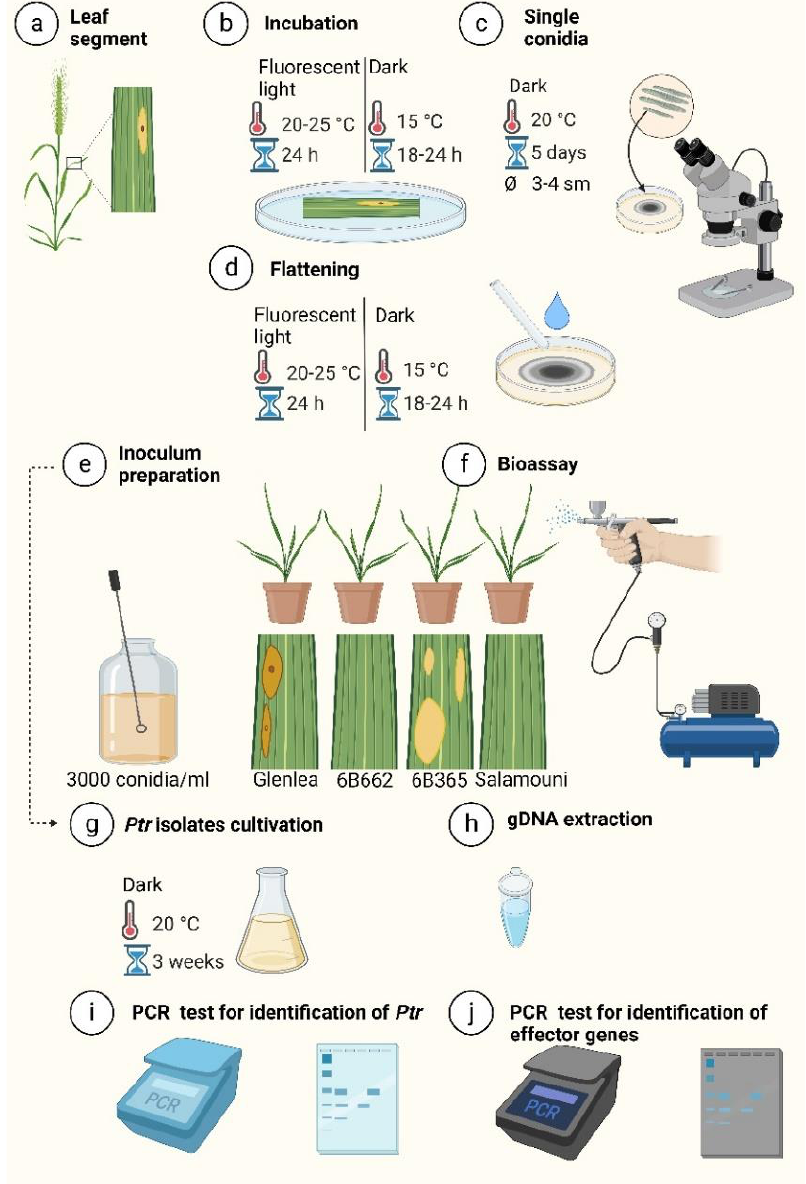
Figure 1. Step-by-step workflow of the characterization of tan spot races and identification of effector genes: ( a ) leaf segment affected by tan spot; ( b ) induction of conidia on leaf segment; ( c ) the cultivation of individual conidia on selective medium (V8-PDA); ( d ) flattening followed by incubation for conidia formation; ( e ) adjusting the concentration of inoculum; ( f ) inoculation with conidia suspension (Race 1 shown in the figure as an example of symptom appearance); ( g ) cultivation of Ptr isolates for gDNA extraction; ( h ) gDNA extraction; ( i ) PCR assay for identification of Ptr ; ( j ) PCR assay for identification of effector